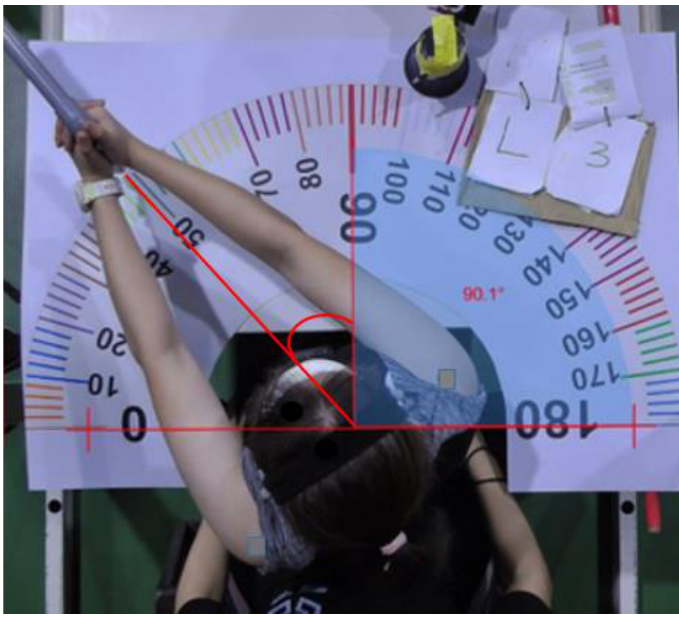
Figure 2. Two-dimensional video analysis for the measurement of trunk rotation.